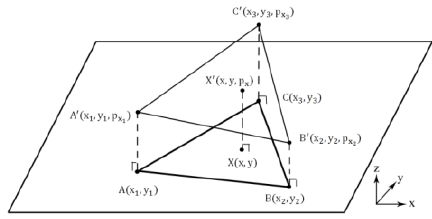
Figure 2. Interpolation of x parallax using TIN surface As shown in Fig. 4, a point